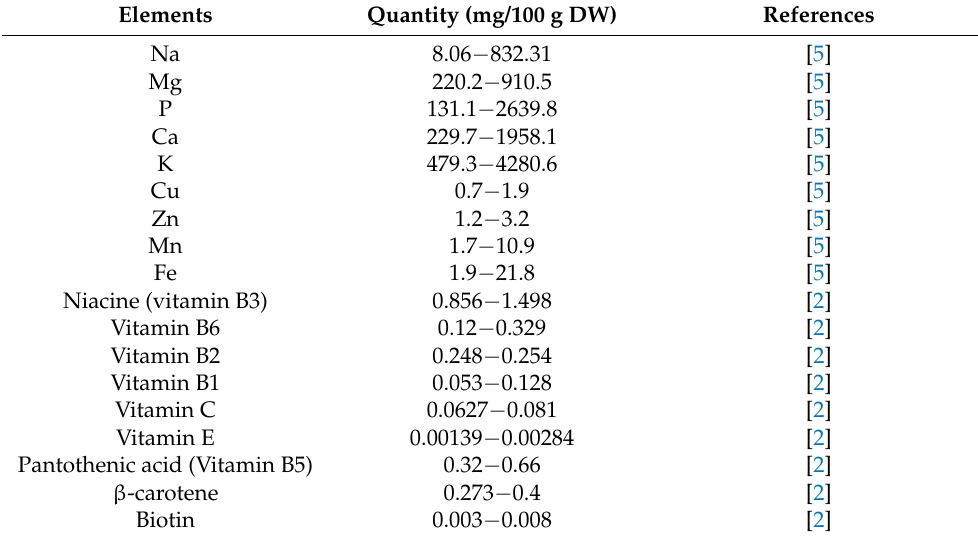
Table 1. Mineral and vitamin compositions of sweet potato